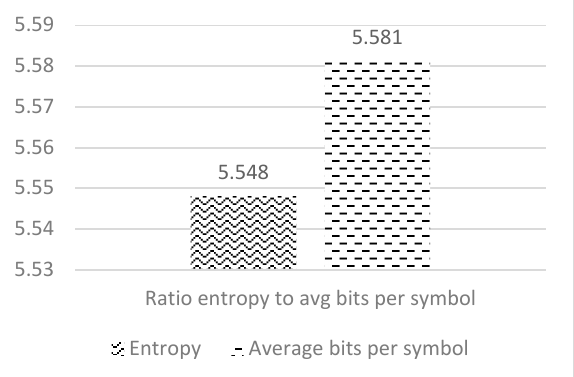
Figure 6. Calculation of entropy and average bit per